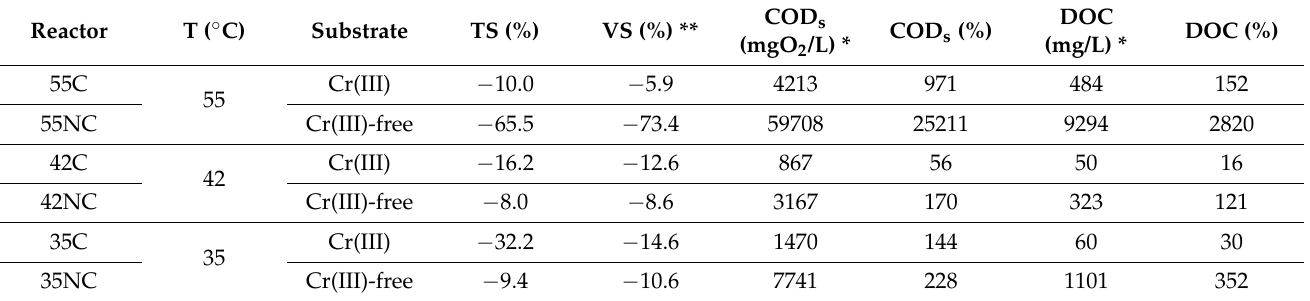
Table 1. Degradation of total (TS) and volatile solid (VS) and solubilisation of chrome-tanned (C) and chromium-free (NC) leather shavings at different temperatures, after 55